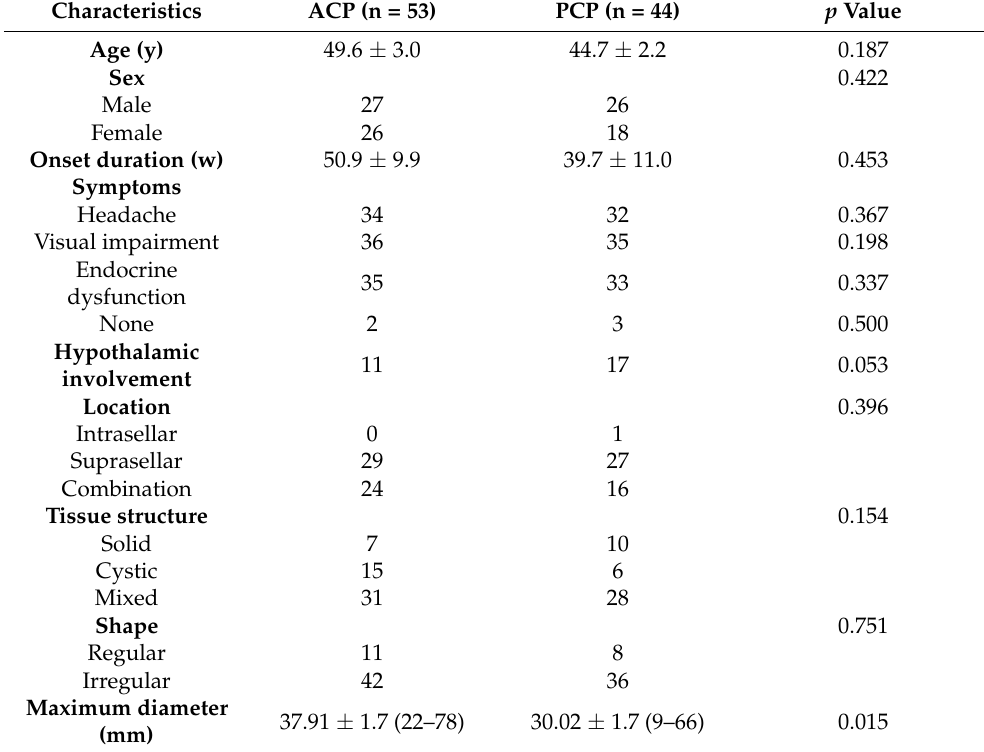
Table 1. The characteristics of the patients and